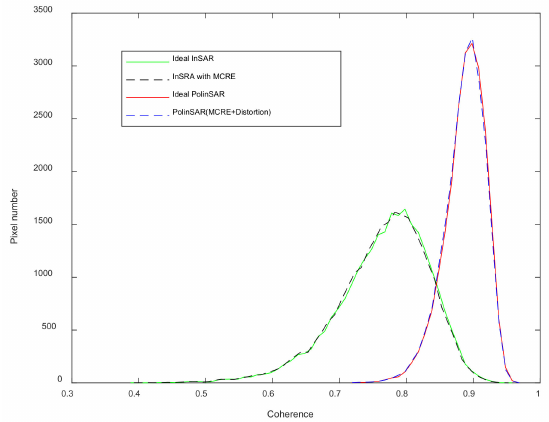
Figure 12. Histogram of coherence.